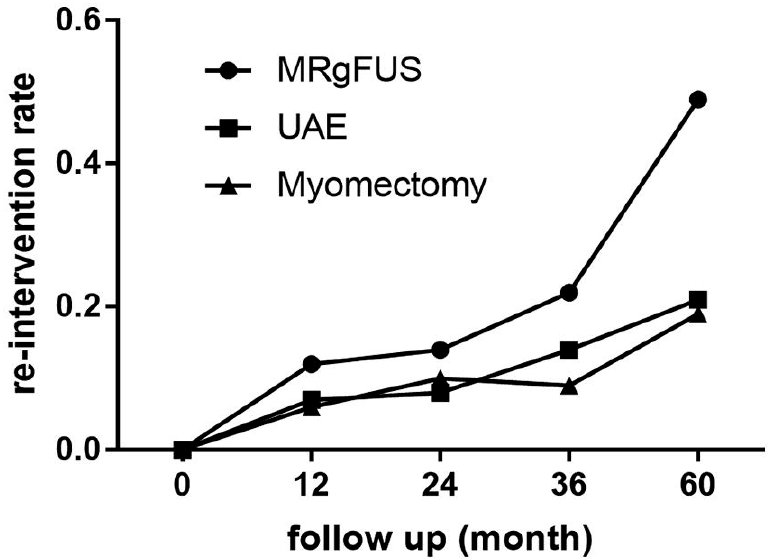
Figure 2. Reintervention rate after first non-surgical intervention of uterine fibroids. Pooled analysis of 42,103 patients. MRgHIFU: UAE: uterine artery embolization. Reprinted with permission from: Xu F et al. The comparison of myomectomy, UAE and MRgFUS in the treatment of uterine fibroids: a metaanalysis [33].